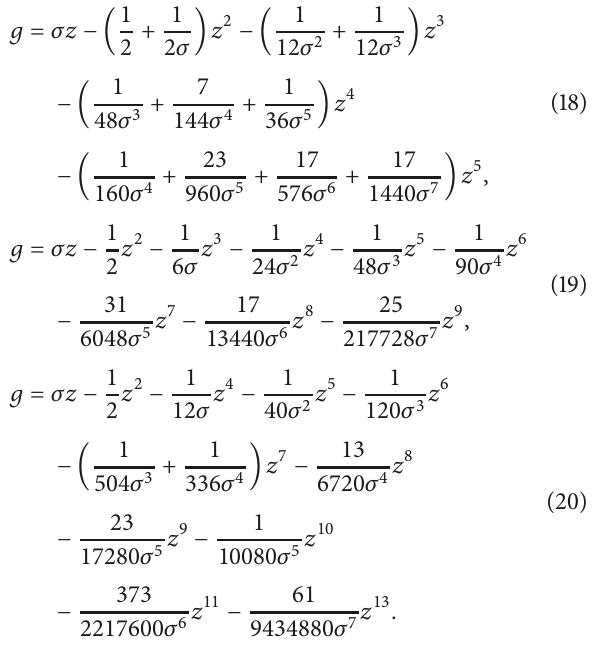
for 𝑧 ∈ [𝑧 0 , 1] . Figure 3 describes the behavior of 𝑔(𝑧) with the changes of parameter 𝛼 ; from Figure 3 we note that the diffusion flux 𝑔(𝑧) increases sharply with the increasing of 𝛼 . Similarly, (9)-(10) can be solved for 𝑛 = 1.0 , ℎ(𝑧) = 1 − 𝑧 , 𝑘(𝑧) = 𝑧, 𝑧 2 , 𝑧 3 . The corresponding approximate solutions are, respectively, given in (18)–(20).